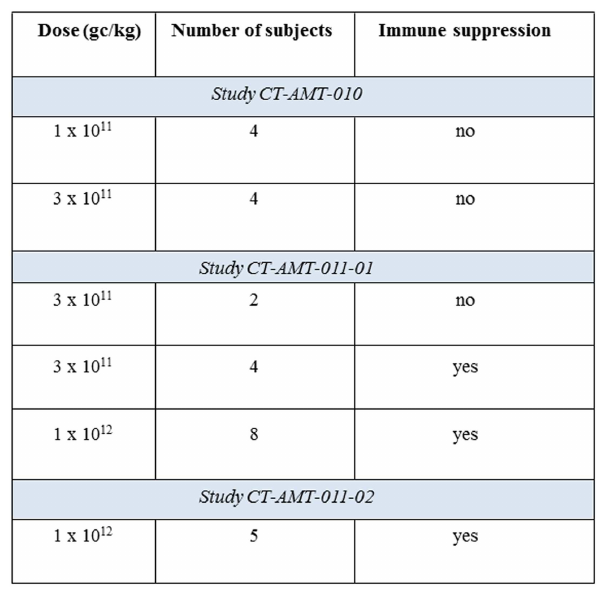
FIGURE 1 | Summary of the clinical studies with alipogene tiparvovec